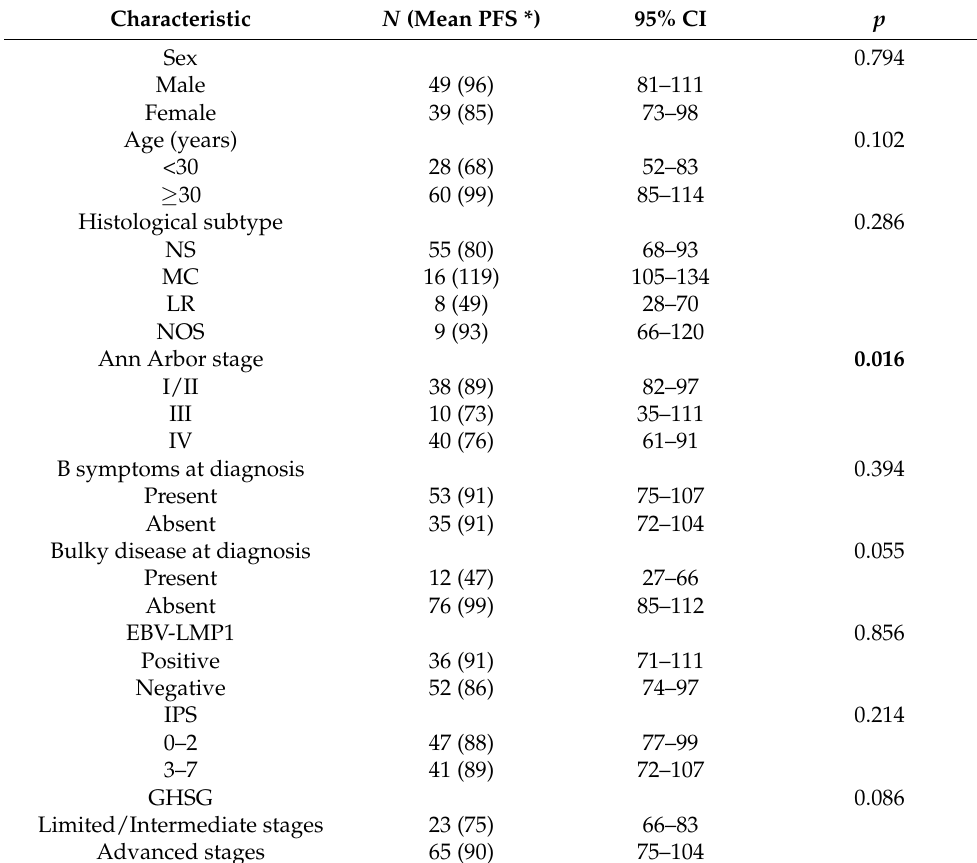
Table 4. Univariate analysis for progression-free